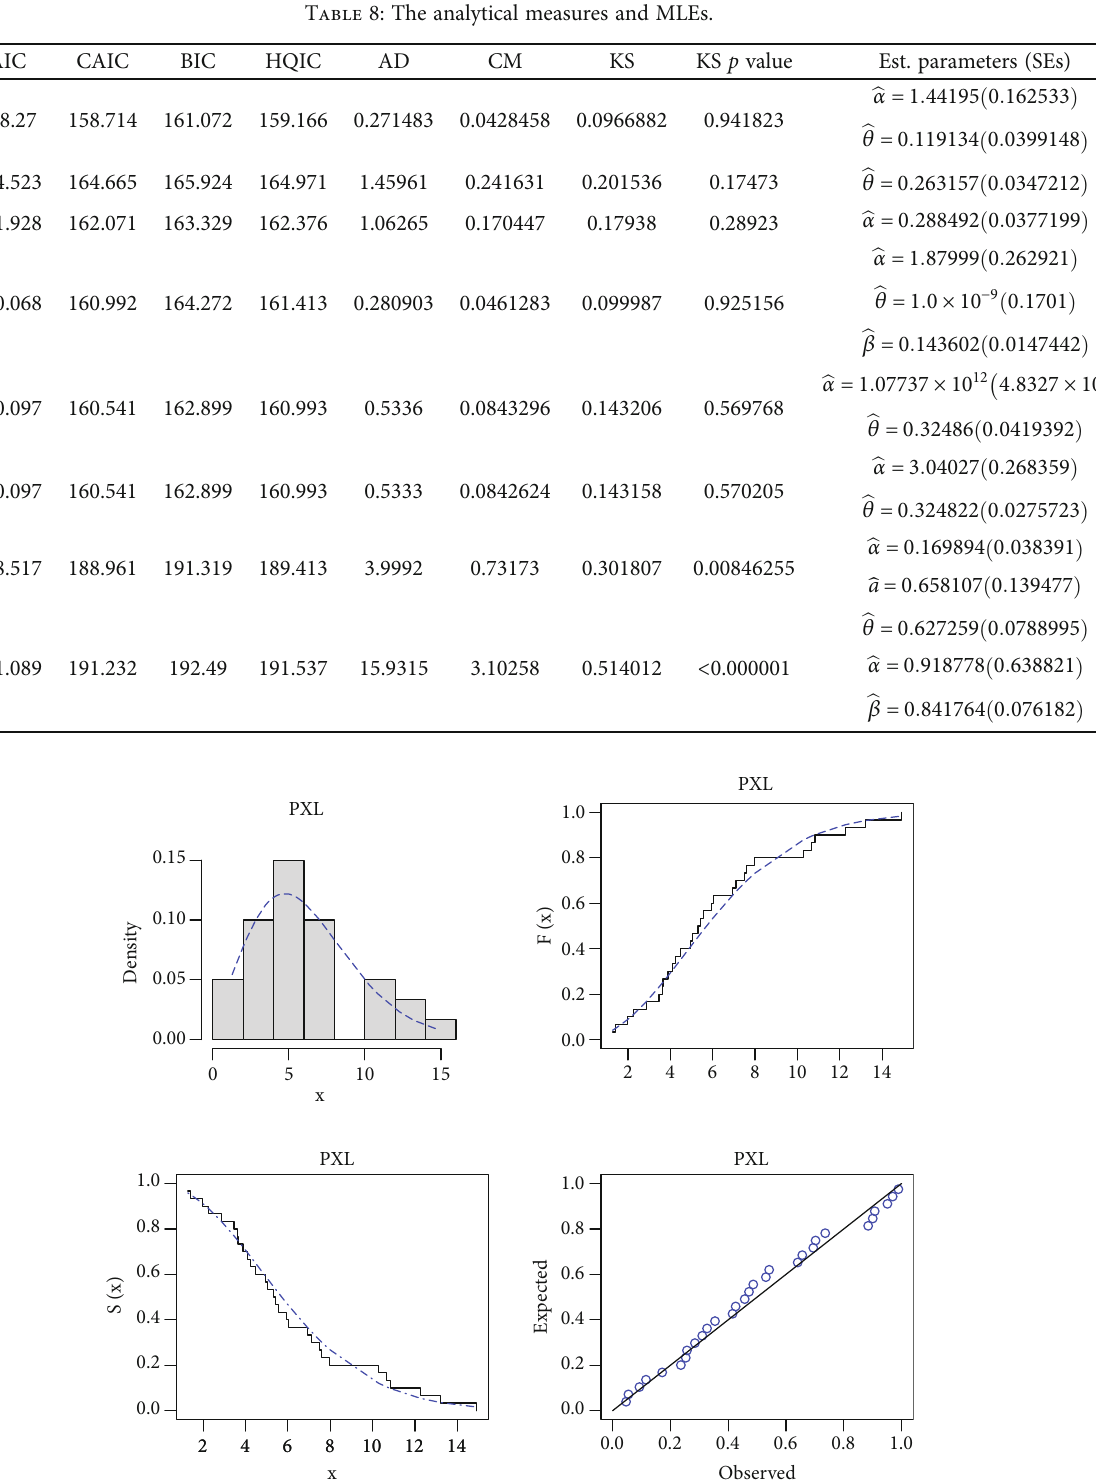
Figure 4: Histogram with the estimated PDF, CDF, SF, and P-P